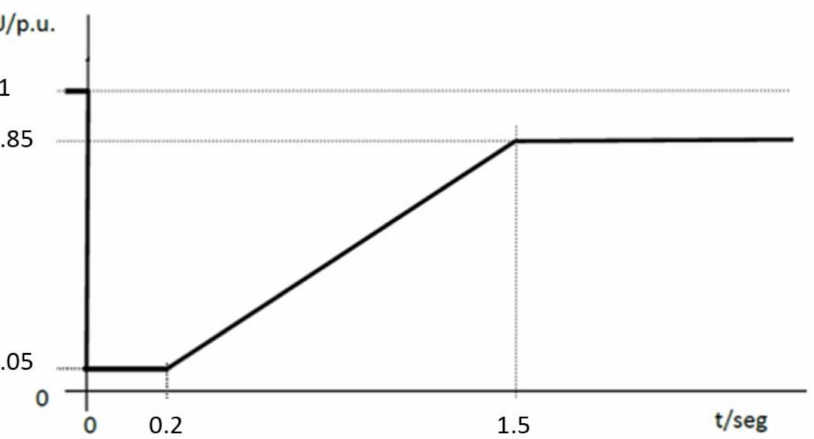
Figure 2. Low-voltage ride-through profile applied to type B and type C electric power-generating module